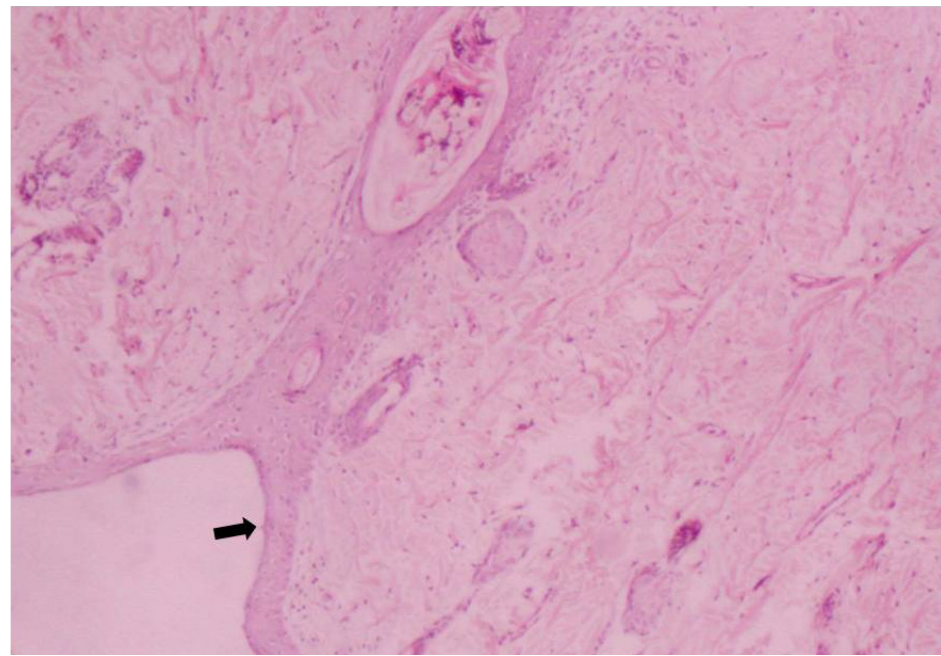
FIGURE 3 - Completed epithelialization (black arrow) in saline treated group (HE,